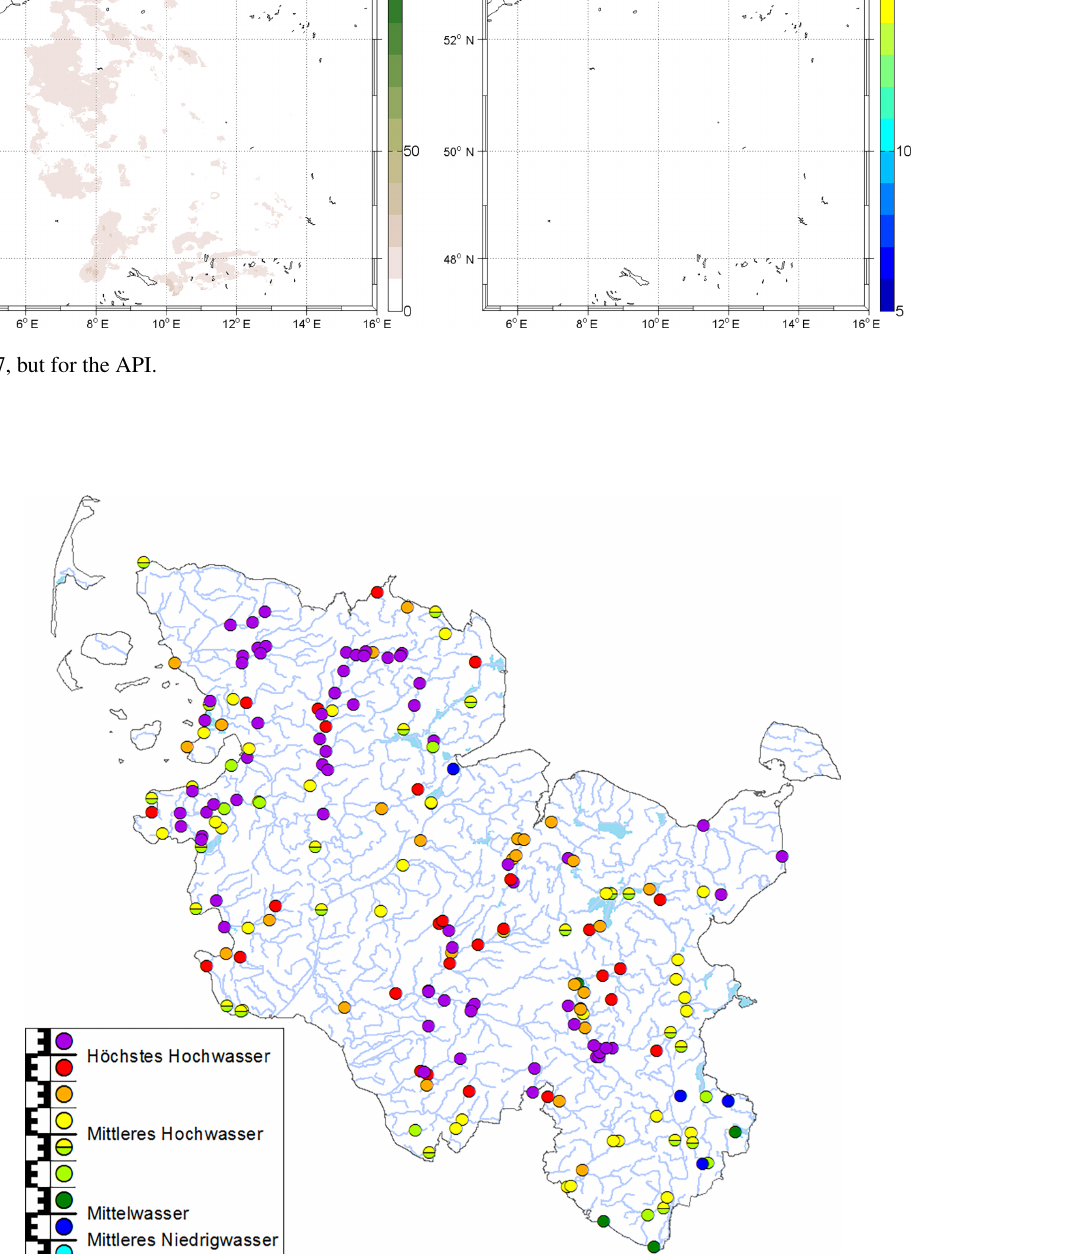
Figure 9. Gauge data in Schleswig-Holstein, showing exceedance of highest high-water levels (mauve), medium high-water levels (yellow to red), medium water levels (green to yellow), medium low-water levels (dark blue), and lower levels (light blue) during the December 2014 flood. This map from the LKN–SH and LLUR–SH (2005) report was kindly provided by Thomas Hirschhäuser